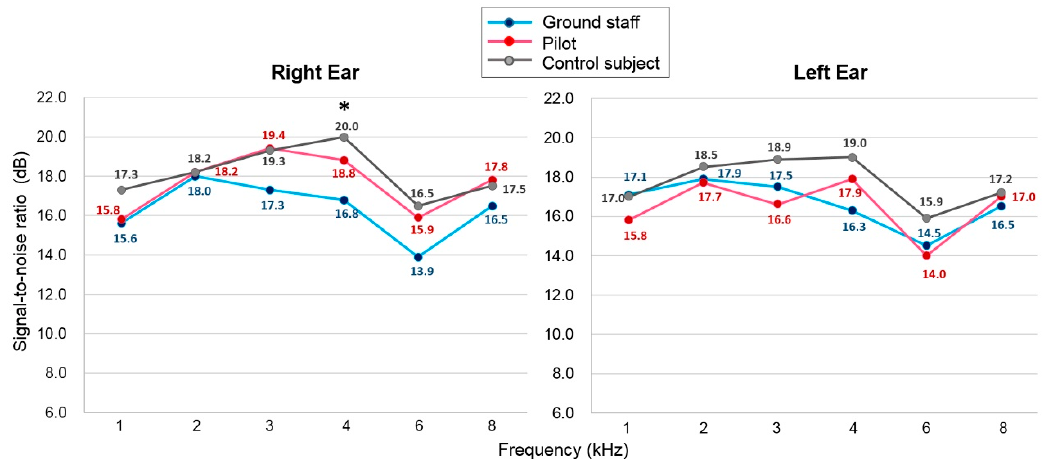
Figure 2. Recent signal-to-noise ratios (SNR) of the distortion-product optoacoustic emissions in the three groups. The value of each data point indicates the average SNR across subjects at the corresponding frequency. * indicates p < 0.05, compared between the ground staff and control subjects.